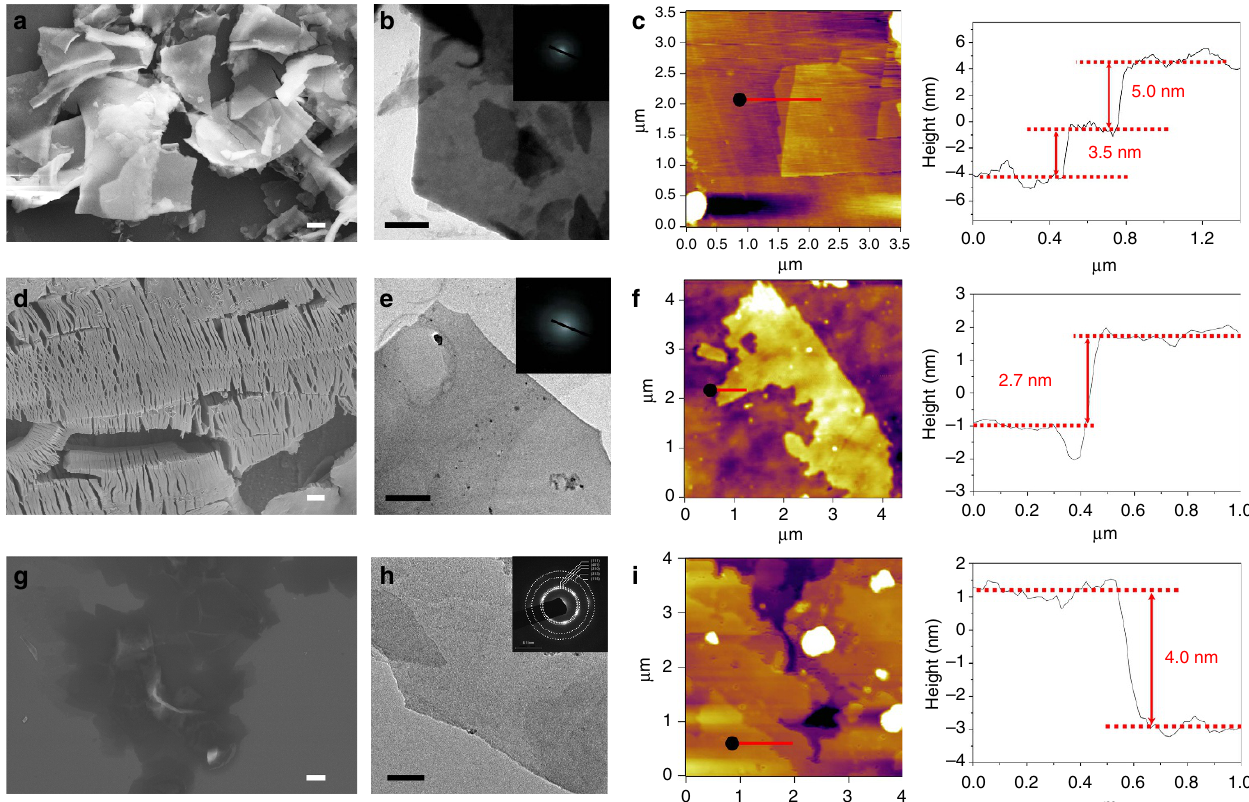
Figure 4 | Characterizations of the oxide nanosheets. ( a ) SEM, ( b ) TEM (inset, corresponding electron diffraction pattern) and ( c ) AFM characterizations of the ZrO 2 nanosheets. ( d ) SEM, ( e ) TEM (inset, corresponding electron diffraction pattern) and ( f ) AFM characterizations of the Al 2 O 3 nanosheets. ( g ) SEM, ( h ) TEM (inset, corresponding electron diffraction pattern) and ( i ) AFM characterizations of the Y 2 O 3 nanosheets. Scale bars, 2 m m ( a , d , g ), 500nm ( b , e ) and 50nm ( h